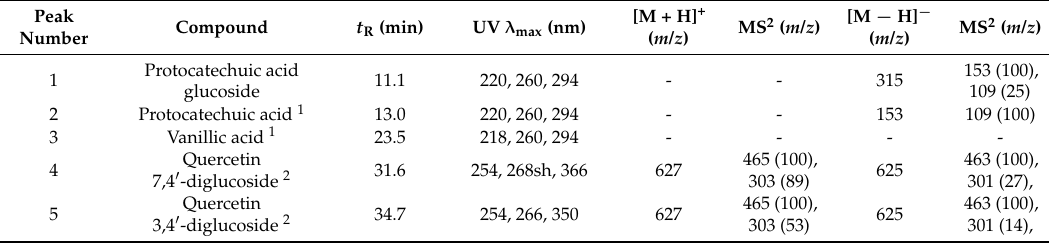
Table 2. Retention times, UV, MS, and MS 2 data of phenolic acids and flavonols in the onion aqueous